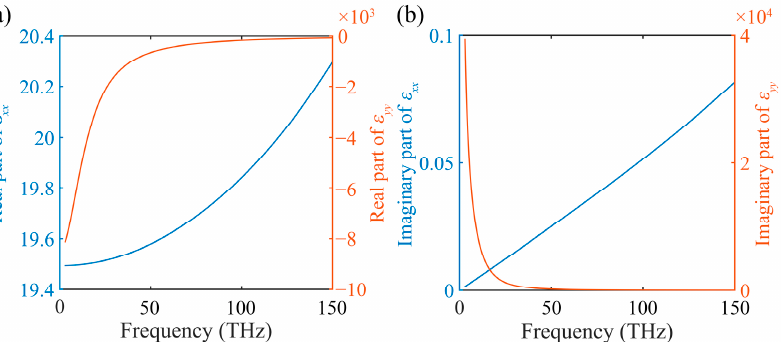
ε ε and ) of yy xx